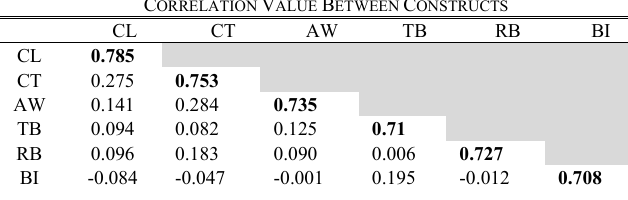
TABLE 6 C ORRELATION V ALUE B ETWEEN C